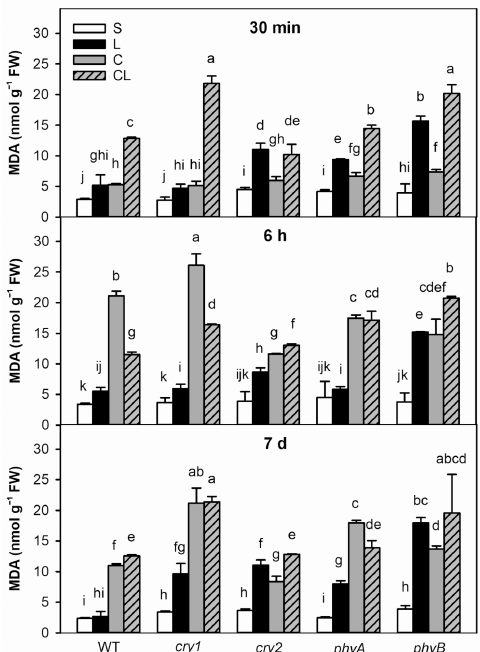
Figure 2. Membrane oxidative damage shown as malondialdehyde (MDA) levels in leaves of plants exposed to standard (S), low light (L), cold (C) and combined cold and low light (CL) conditions for 30 min, 6 h or 7 d. Means ± SD are shown in plots. Between-treatment and between-genotype differences were evaluated by one-way ANOVA with Tukey’s test ( p < 0.05, n = 3). Statistical difference is indicated by different